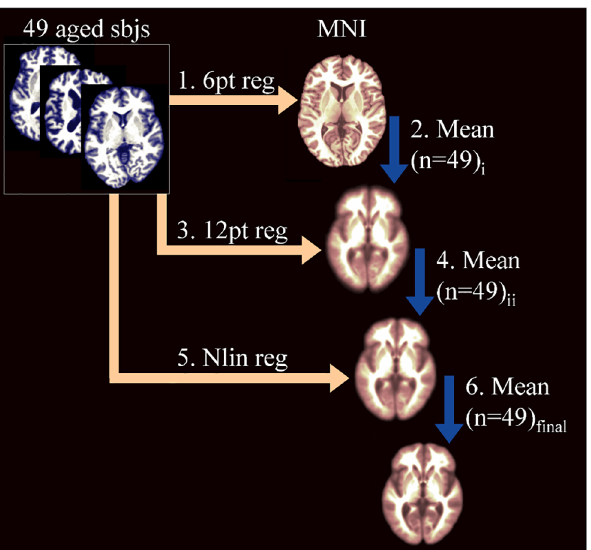
Fig 1. Procedure to create a brain MRI standard space representative of aged ( > 60 years) subjects. This is in the orientation of the commonly used Montreal Neurological Institute (MNI) template but reflects features of brain ageing, e.g. larger ventricles; sbjs = subjects; pt = point; reg = registration; Nlin = nonlinear.